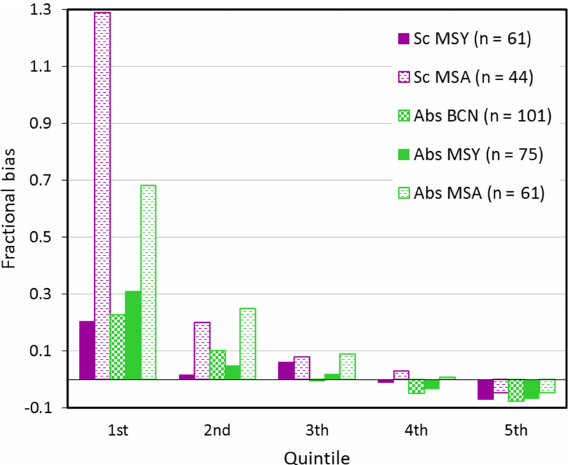
Figure 5. Average fractional bias (FB) calculated for the observed- modelled data pairs of scattering (Sc) and absorption (Abs) coeffi- cients at BCN, MSY and MSA broken down by quintile from the lowest to highest scattering and absorption coefficient values. n ac- counts for the number of daily data points used in the FB calcula-